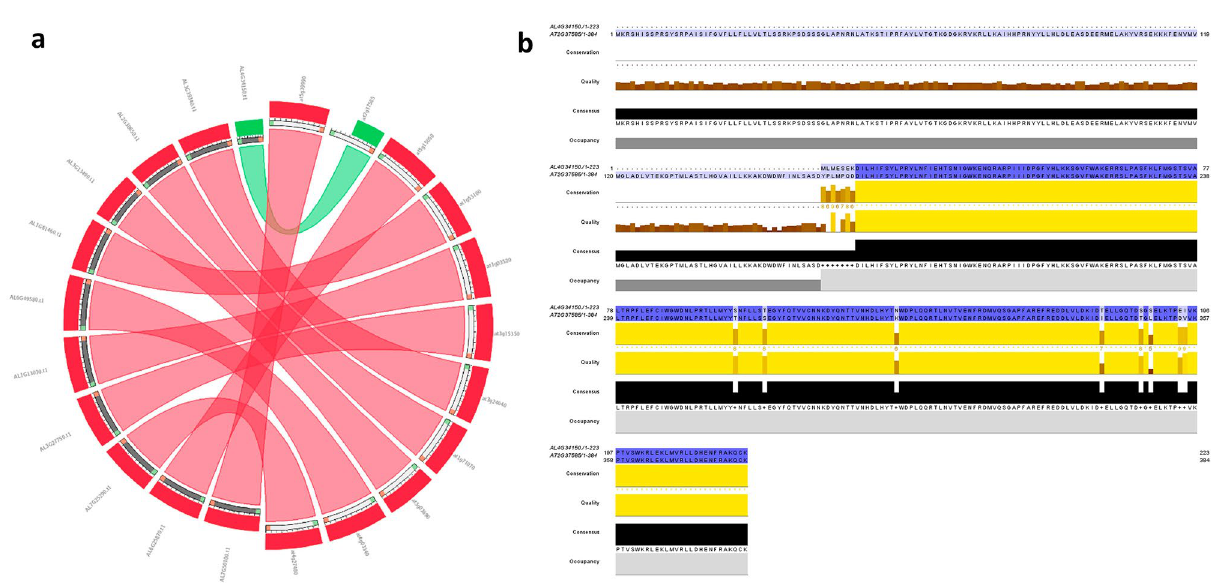
Figure 4. Comparative analyses of ATGLCAT14C ( AT2G37585 ) and AL4G34150 genes. ( a ) Synteny of Arabidopsis thaliana and Arabidopsis lyrata GLCAT genes. Weak sequence similarity (green ribbon) between ATGLCAT14C and its ortholog AL4G34150 in A. lyrata. ( b ) Pairwise comparison between ATGLCAT14C and its ortholog AL4G34150 displaying conserved regions (highlighted in dark blue and yellow blocks) as illustrated by Jalview 33 . The first 167 amino acid residues in ATGLCAT14C are conspicuously absent in